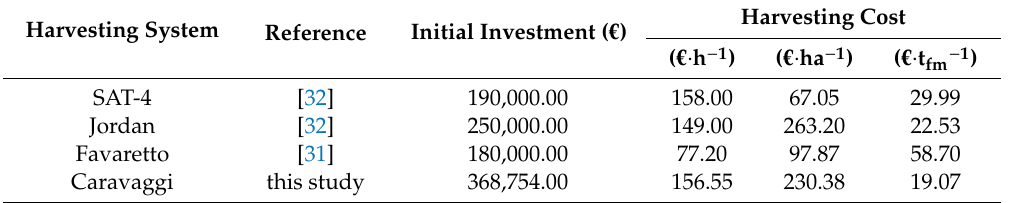
Table 4. Pruning harvesting systems’ costs (no wood chips’ transports included) and comparison with previous studies on similar